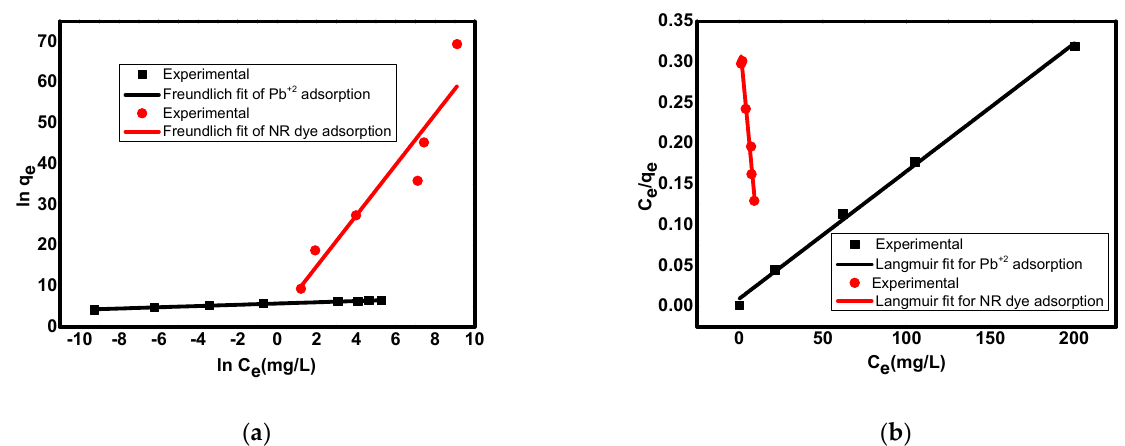
Figure 8. Freundlich adsorption isotherm ( a ); Langmuir adsorption isotherm ( b ) for Pb 2+ and NR dye adsorption over MnFe 2 O 4 /GO nanocomposite. Table 1. Freundlich and Langmuir adsorption isotherms different parameters for Pb 2+ ions and NR dye adsorption over MnFe 2 O 4 /GO